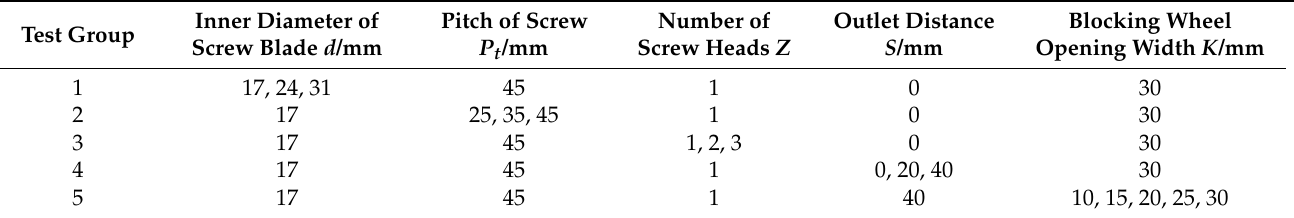
Table 2. Single factor simulation test table.